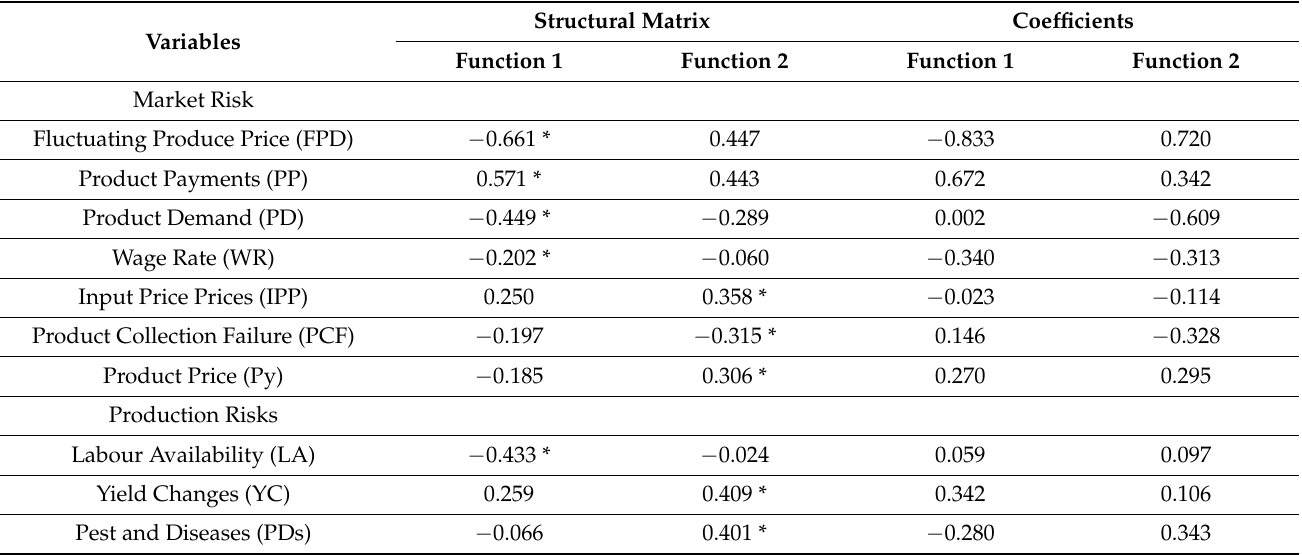
Table 3. The discriminating risk